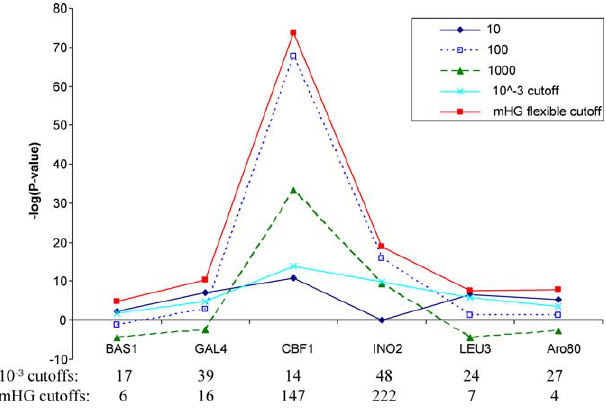
Figure 5. Comparison between HG and mHG Enrichment The mHG and HG methods were applied to ChIP–chip data of six TFs. The sequences were ranked according to the ChIP–chip binding signal, and the enrichment of the correct binding motif was recorded using mHG and HG with fixed target sets containing the top 10, 100, and 1,000 sequences as well as all sequences with ChIP–chip signal , 10 (cid:2) 3 . All scores were corrected for multiple motif testing. The mHG score is also corrected for the multiple cutoff testing. The 10 (cid:2) 3 and mHG cutoffs for each experiment are shown. It can be seen that the two cutoffs are significantly different and that for all the tested TFs mHG produces better results than HG in terms of enrichment of the true motif.